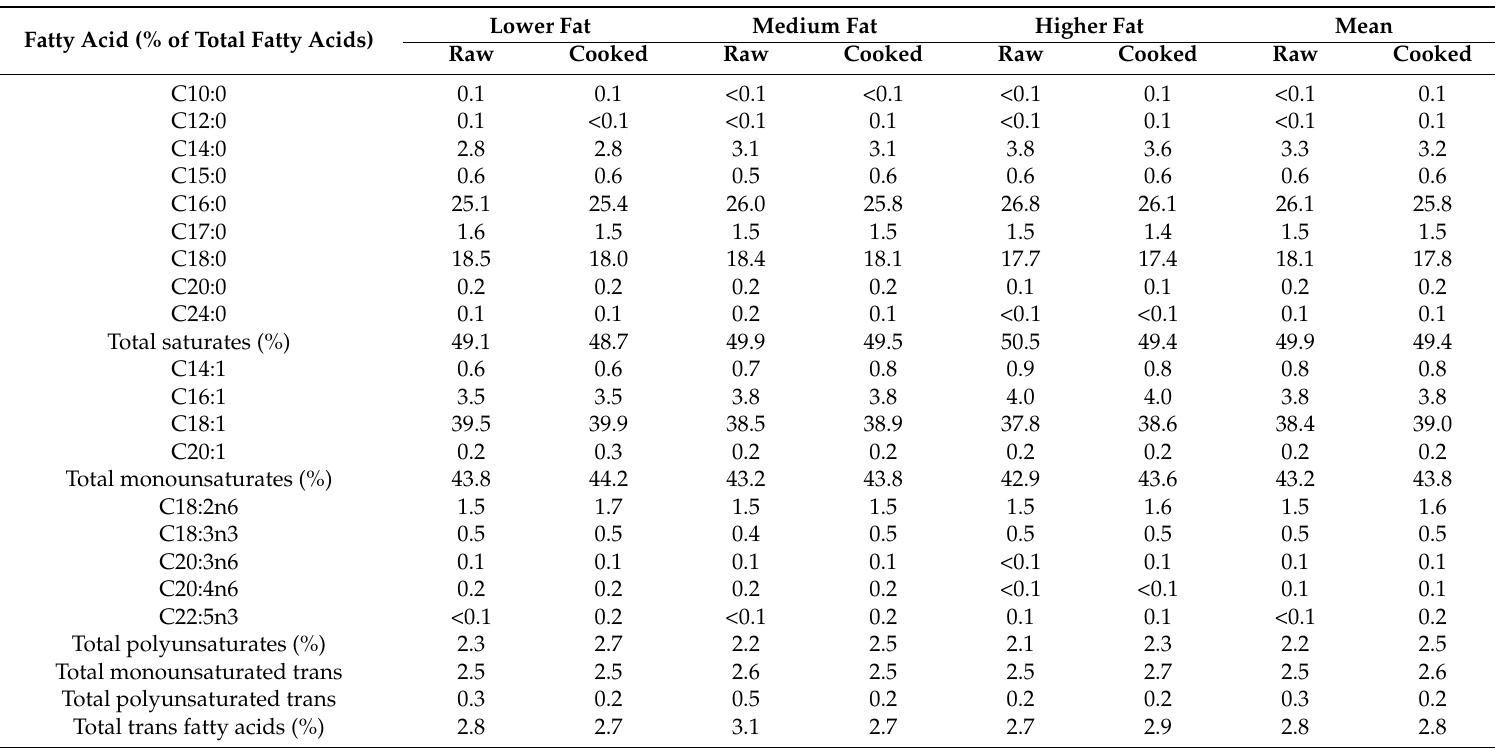
Table 7. Fatty acid profile 1 of composite samples 2 of raw and cooked 3 beef sausages grouped according to fat content. Values are expressed as g/100 g total fatty acids 4